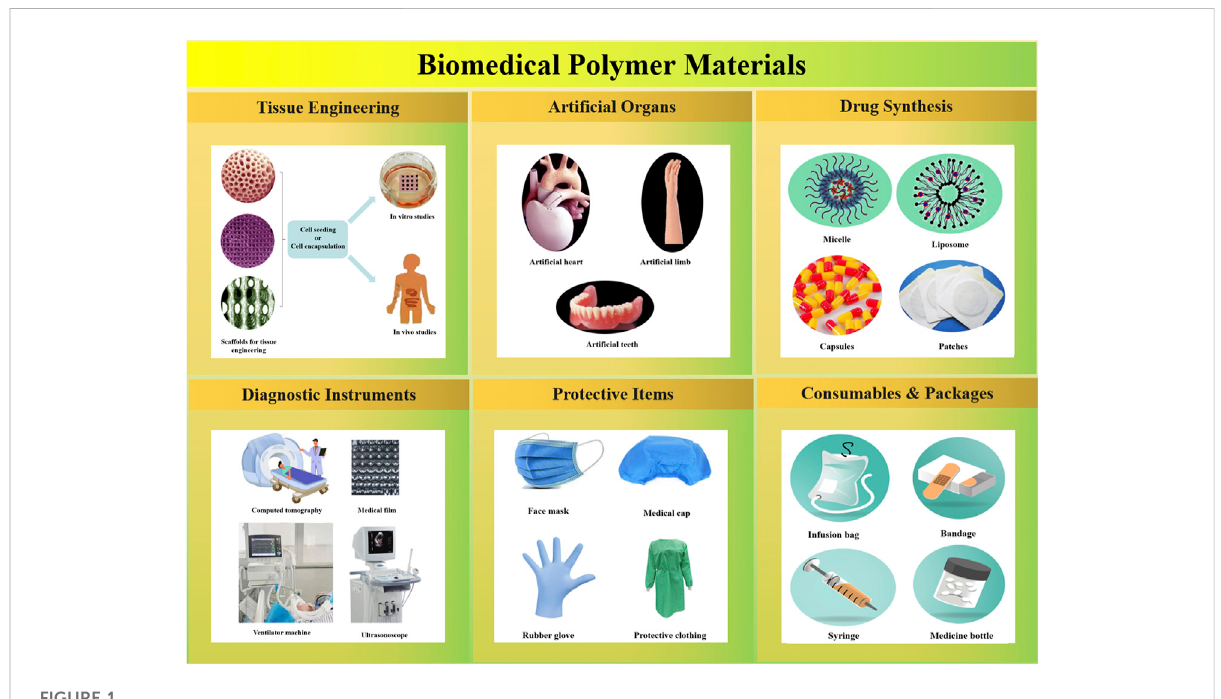
FIGURE 1 Representative biomedical polymer products applied in different fi